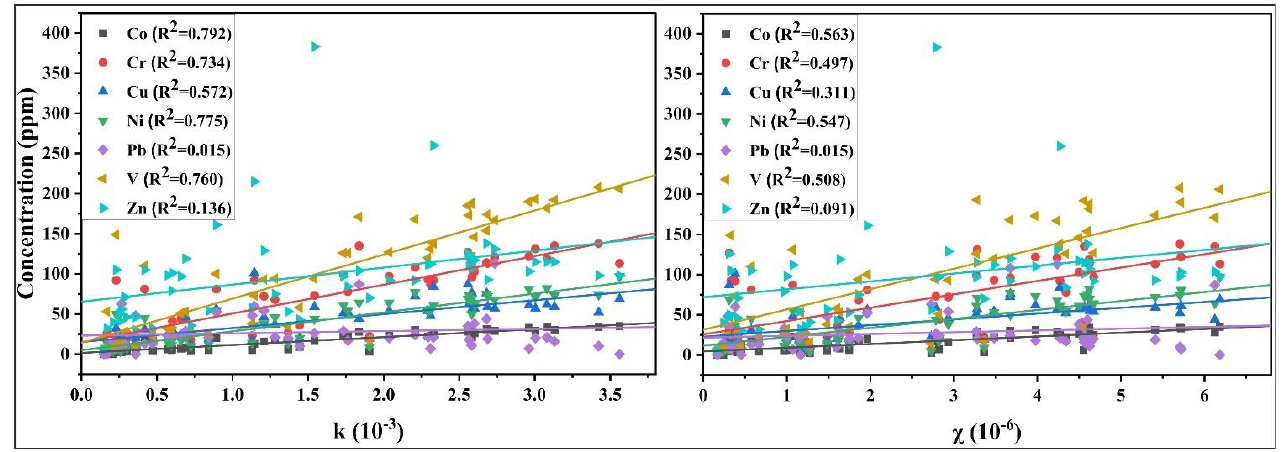
Figure 10. Scatter plot of PTEs with k and χ